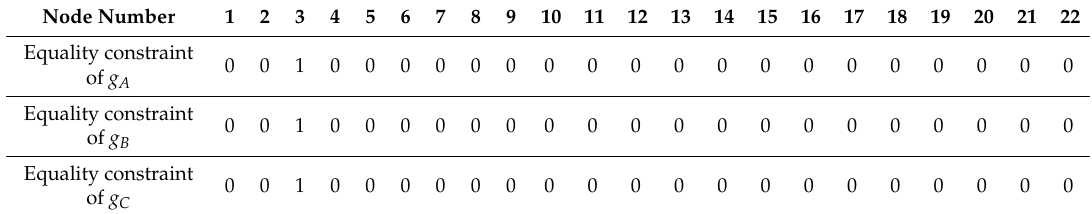
Table 3. Optimum placement of ATCTrs (solution A).